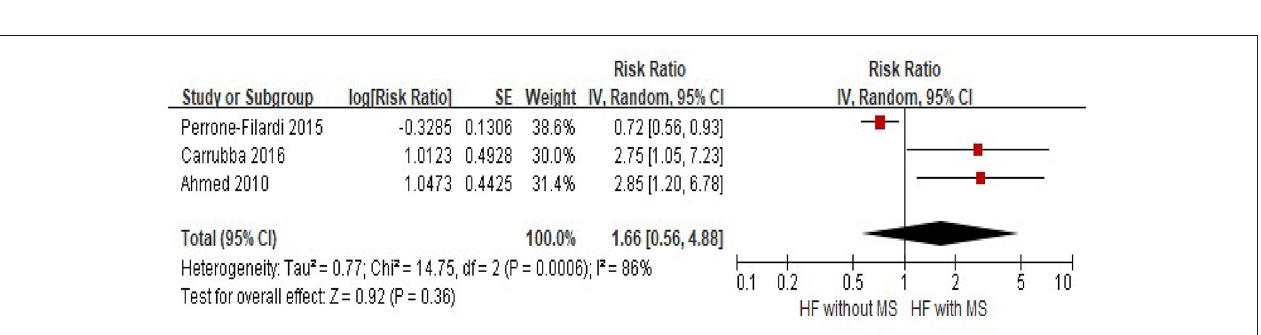
FIGURE 2 | The association of MS and the risk of all-cause mortality in HF patients. CI, confidence interval; HF, heart failure; MS, metabolic syndrome.